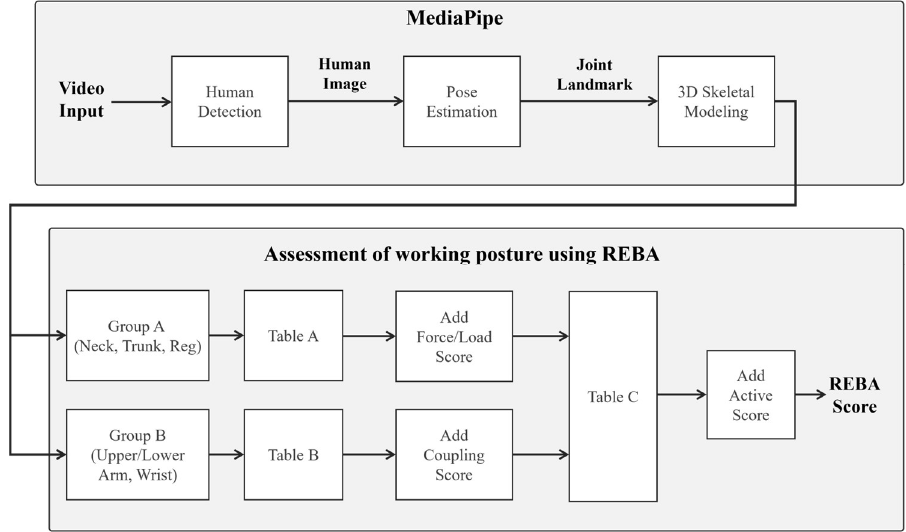
Figure 9. REBA evaluation system using MediaPipe.